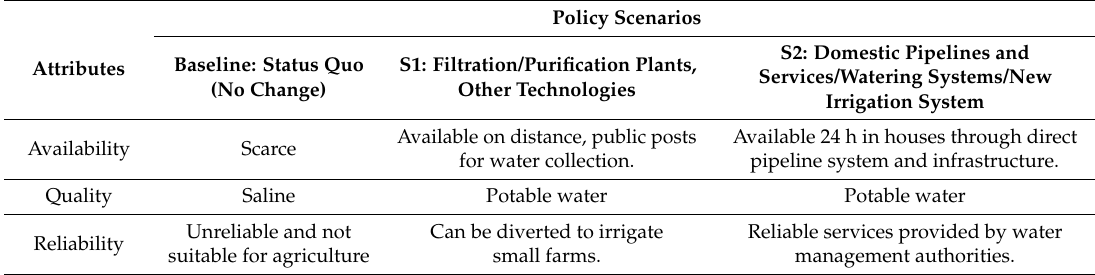
Table 2. Attribute levels and Scenario